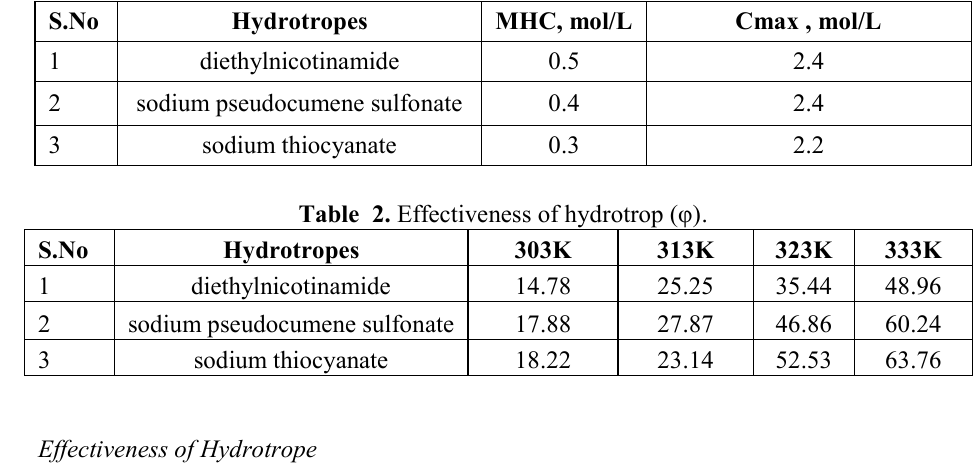
Table 1. MHC and C